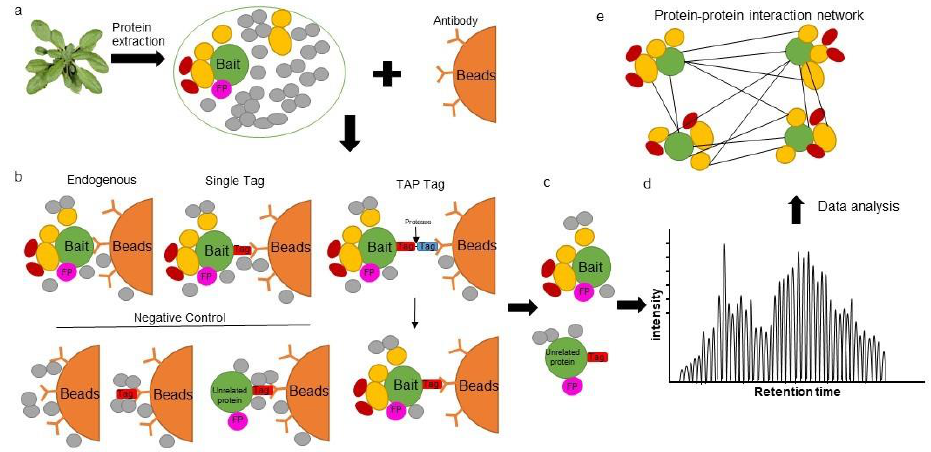
Figure 1. Overview of affinity purification strategies. ( a ) Total protein extraction for affinity purification. ( b ) Bait specific antibodies are linked to beads for protein complex immunoprecipitation under native conditions. Such beads can be used to detect endogenous proteins within a plant, proteins fused displaying a single tag (single affinity purification) or proteins expressing a double (TAP) tag (double affinity purification). Suggested controls used to reduce background contaminants and thus the identification of false positives include using a wild-type plant extract, purification from cells expressing the tag only, or unrelated proteins fused with a tag. ( c ) Several washing steps are used to reduce non-specific interactions. ( d ) Proteins are measured by LC-MS. ( e ) Data analysis to determine a protein–protein interaction network. FP: false positive; UP: unrelated pro- tein.